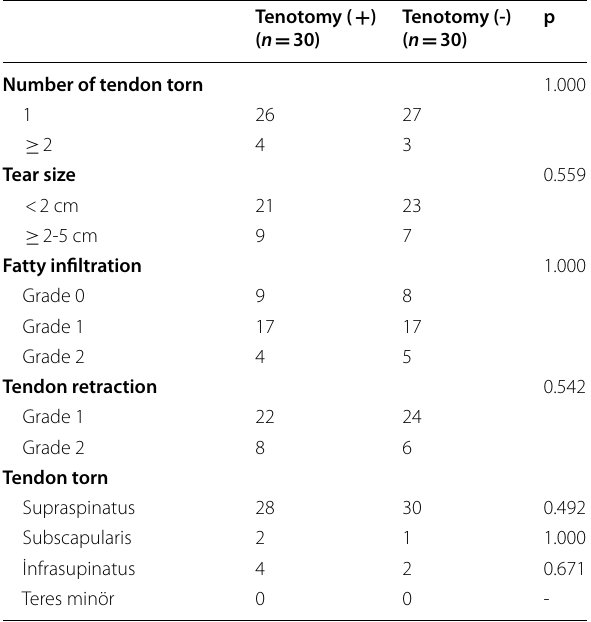
Table 2 Intraoperative tear